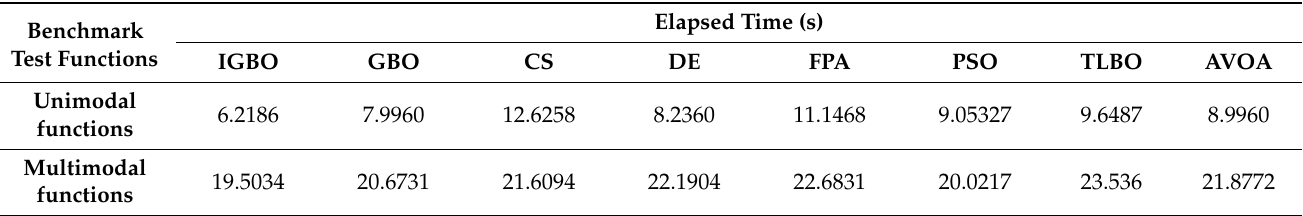
Table 8. Comparison of computational time between IGBO and other